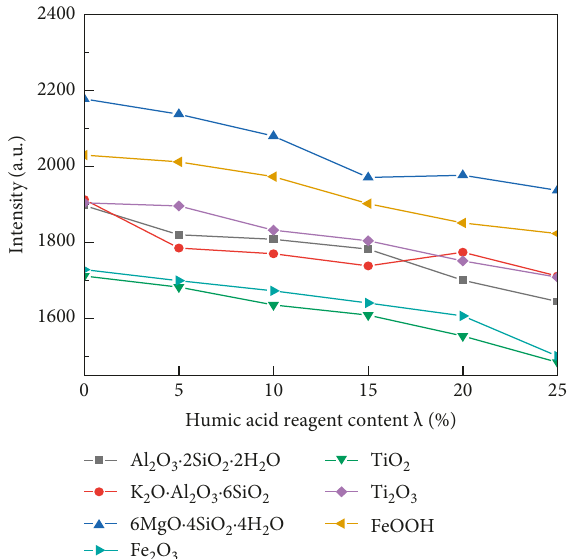
Figure 14: Relationship curve between diffraction peak value of main substances (except SiO 2 ) and the amount of HA reagent.